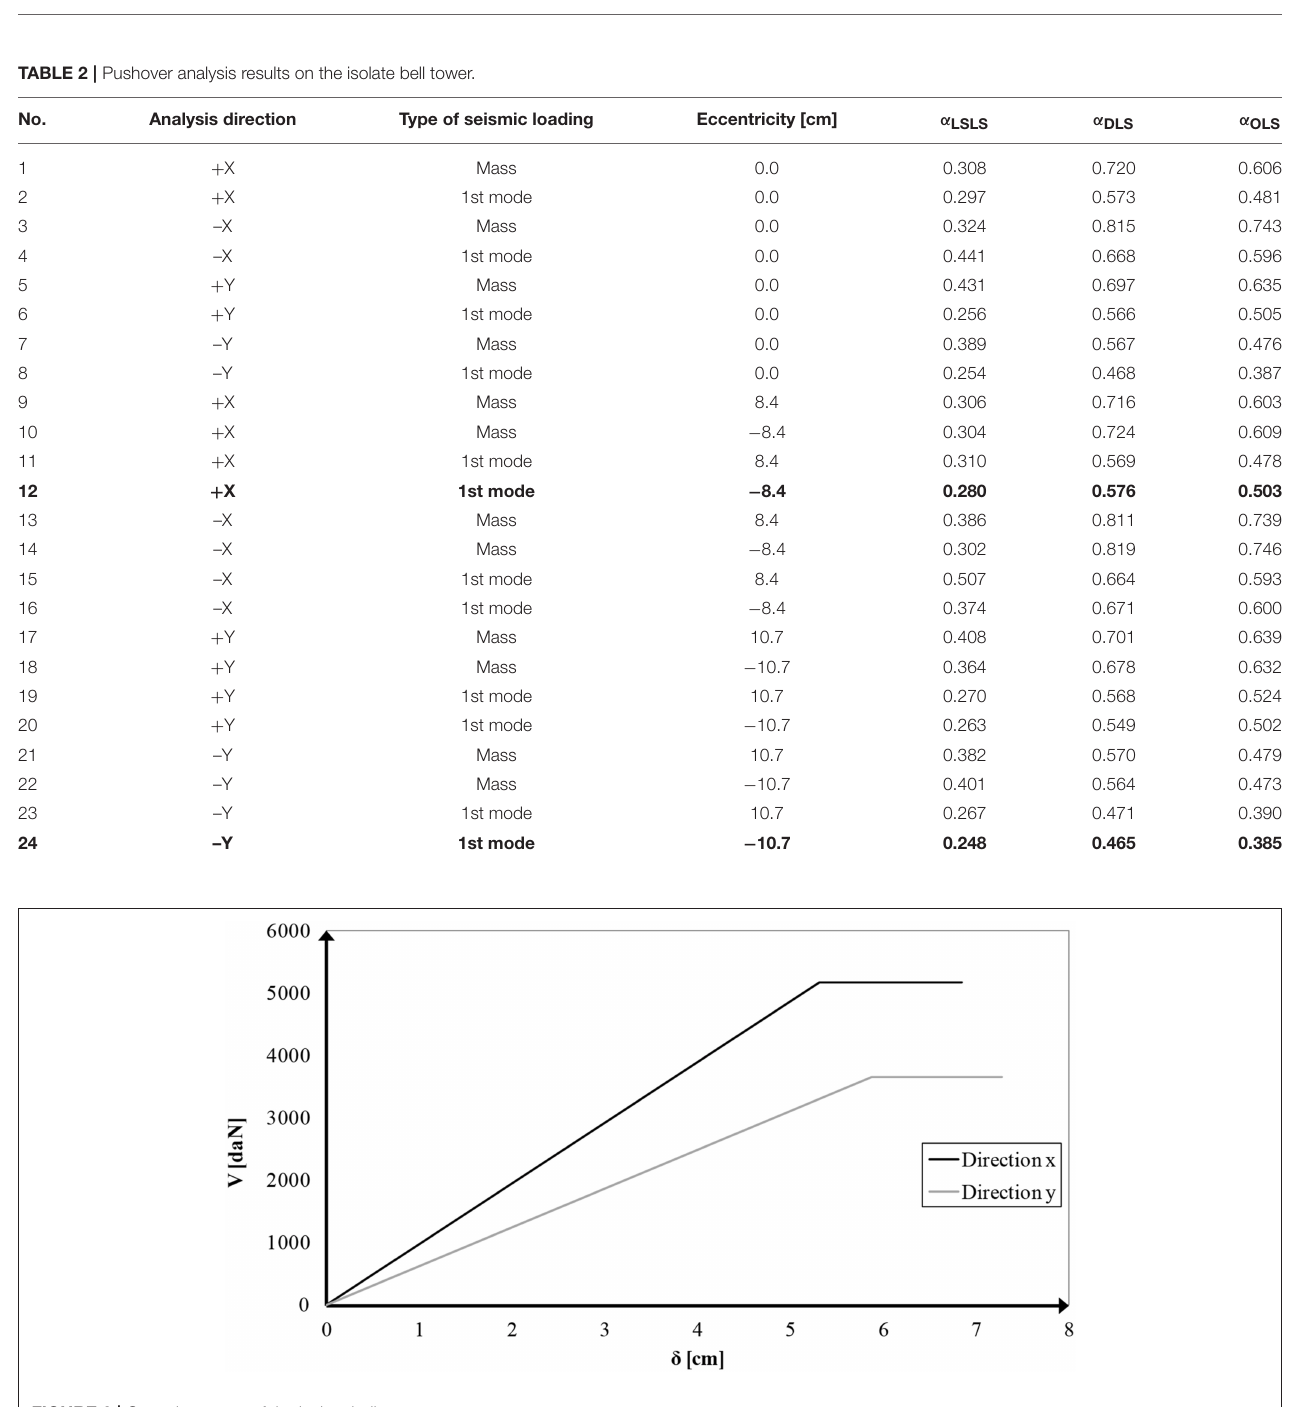
FIGURE 6 | Capacity curves of the isolate bell